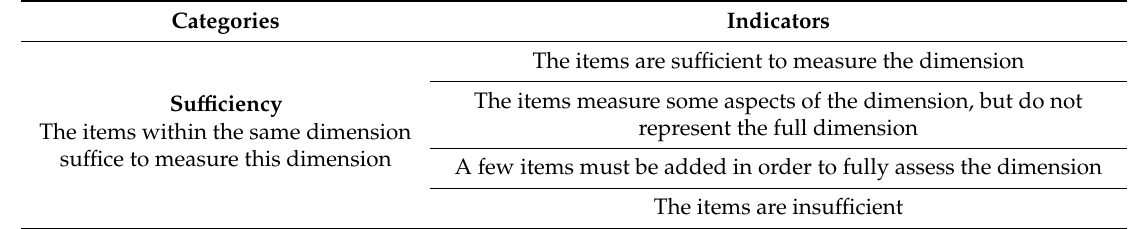
Table 2. Categories and indicators used by the judges to validate the